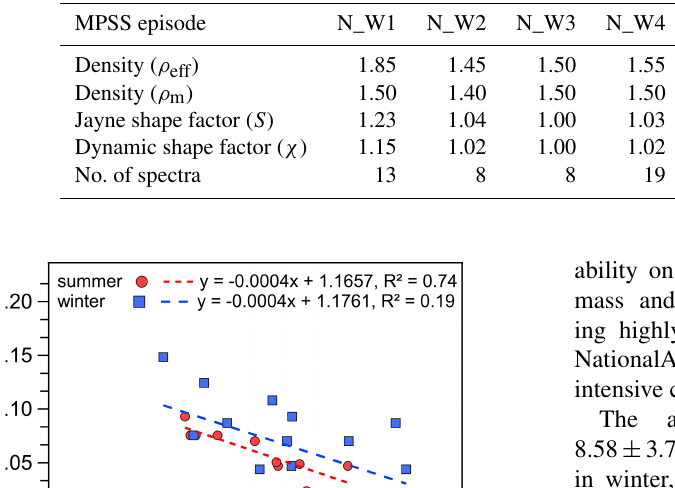
Figure 8. The relationship between density ( ρ m ), calculated according to Eq. (2), and mass fractions of the main NR-PM 1 species. Idealized extrapolation of organics’ densities is added to the summer figure for ρ = 1.2gcm − 3 at 100% Org and ρ = 1.77gcm − 3 for 0% organics. Table 5. Particle effective densities (gcm − 3 ) and shape factors calculated during episodes of high particle contributions to N10–800 using MPSS data.